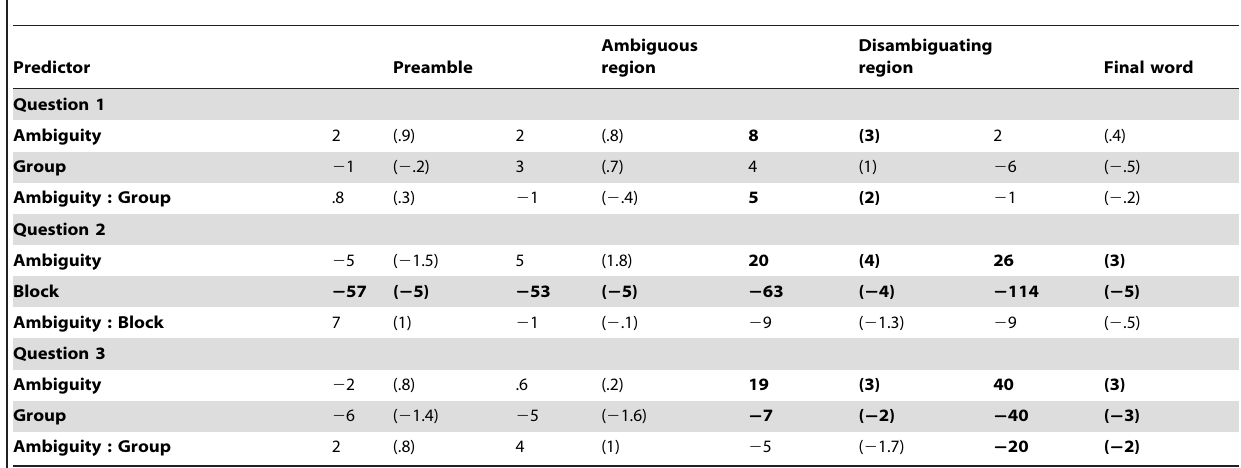
Table 3. Summary of model results at each sentence region in Experiment 2.